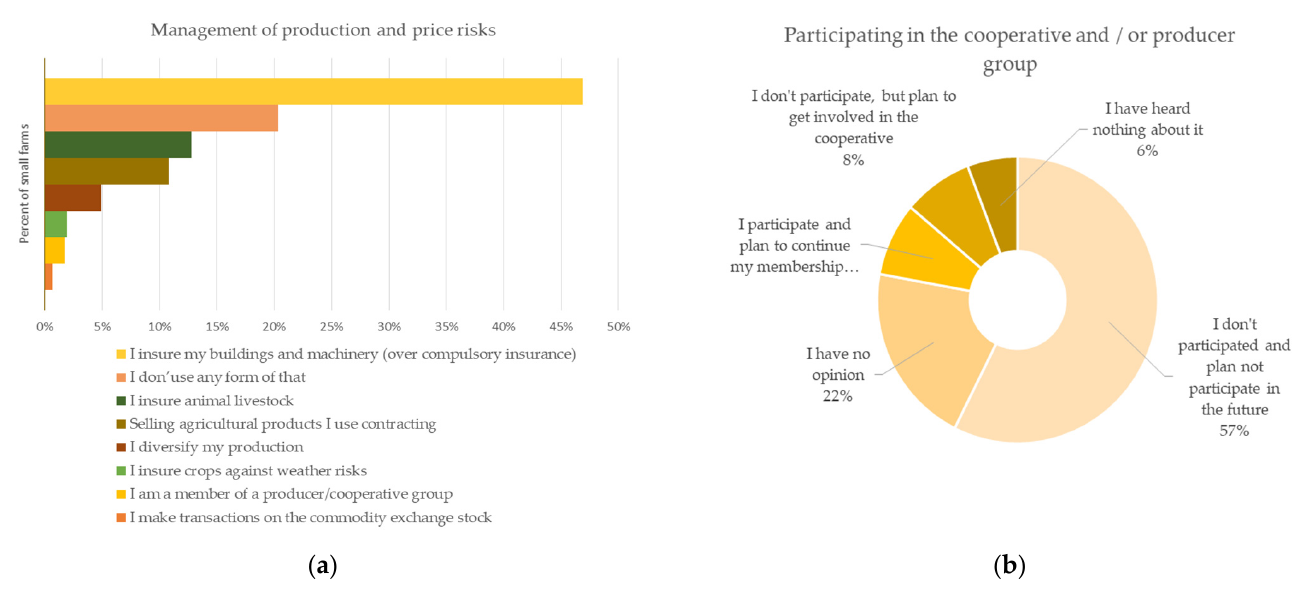
Figure 4. Management of production and price risks ( a ) and willingness to participate in cooperative actions ( b ) in Lithuanian small-scale farms (N = 1002).